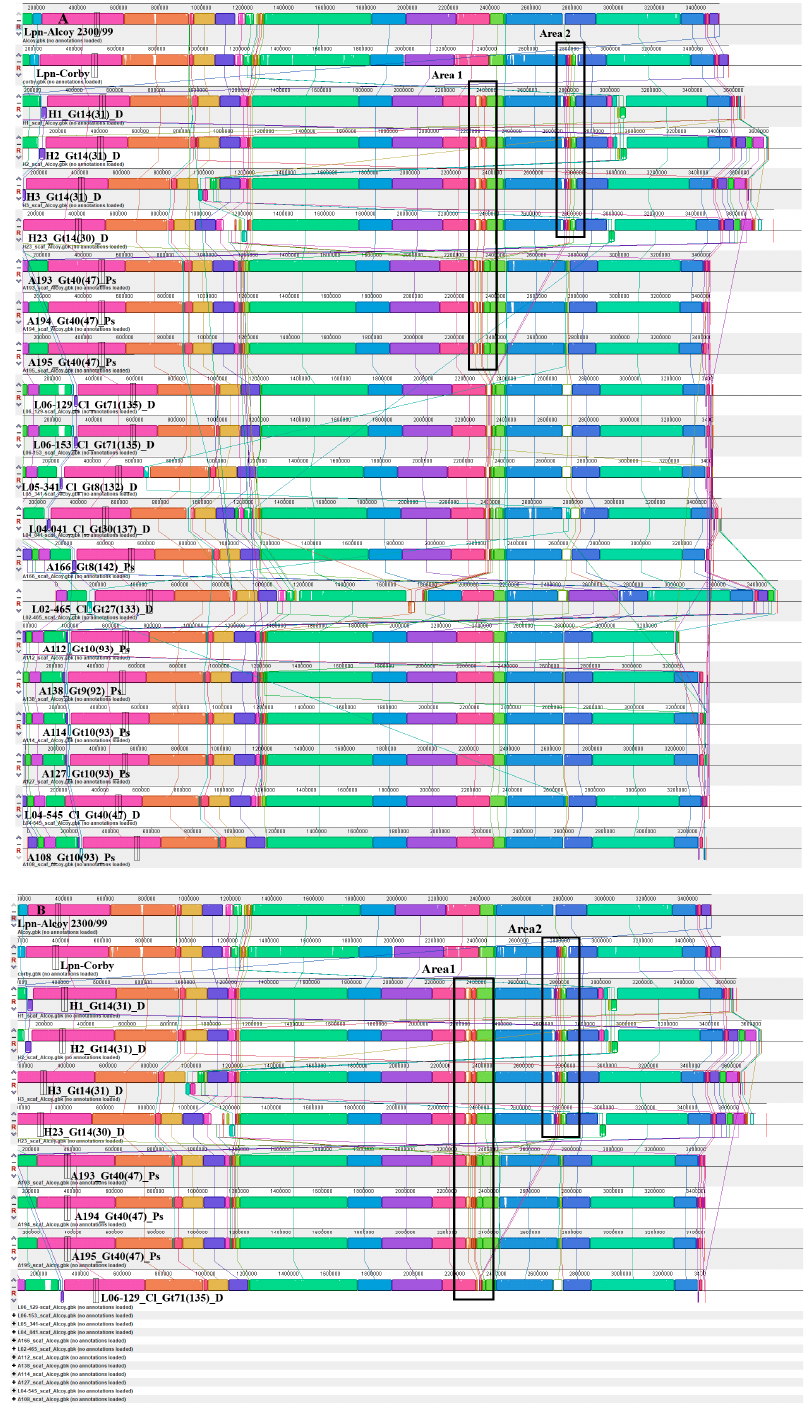
Figure 3. Mauve whole-genome alignments of L. pneumophila strains within Alcoy branch. ( A ) Progressive Mauve was used to compare the complete genomes of isolates assigned to Alcoy against strain Alcoy 2300/99 itself. Contigs have been ordered before by applying the “Move con- tigs” function. Contig borders are shown with red lines within the linear display. Boxes with common colors are pairwise-computed LCBs (locally collinear blocks). Mauve was run using de- fault parameters, as described in (34 and 35). The cluster six organizations, as well as the identity and location of the ~84-kb area 1 and the ~49-kb area 2 elements, are shown . ( B ) Magnified in Mauve.